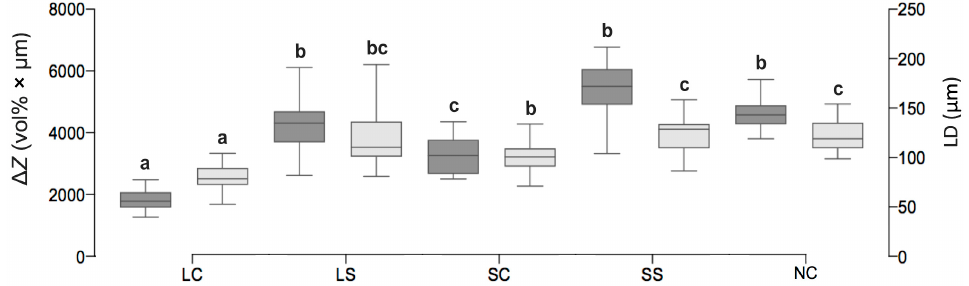
Figure 3. Mineral loss Δ Z (dark grey boxes, left y-axis) and lesion depth LD (light grey boxes, right y-axis) of enamel caries lesions after 10 days of biofilm cultivation. Line and box = median and 25th/75th percentiles; error bars = minimum and maximum. LC: L. reuteri whole culture; LS: L. reuteri culture supernatant; SC: S. oligofermentans whole culture; SS: S. oligofermentans culture supernatant;